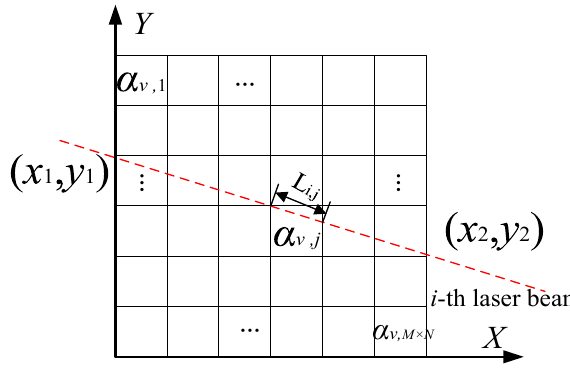
Figure 1. A geometric description of a projection beam and measurement region.